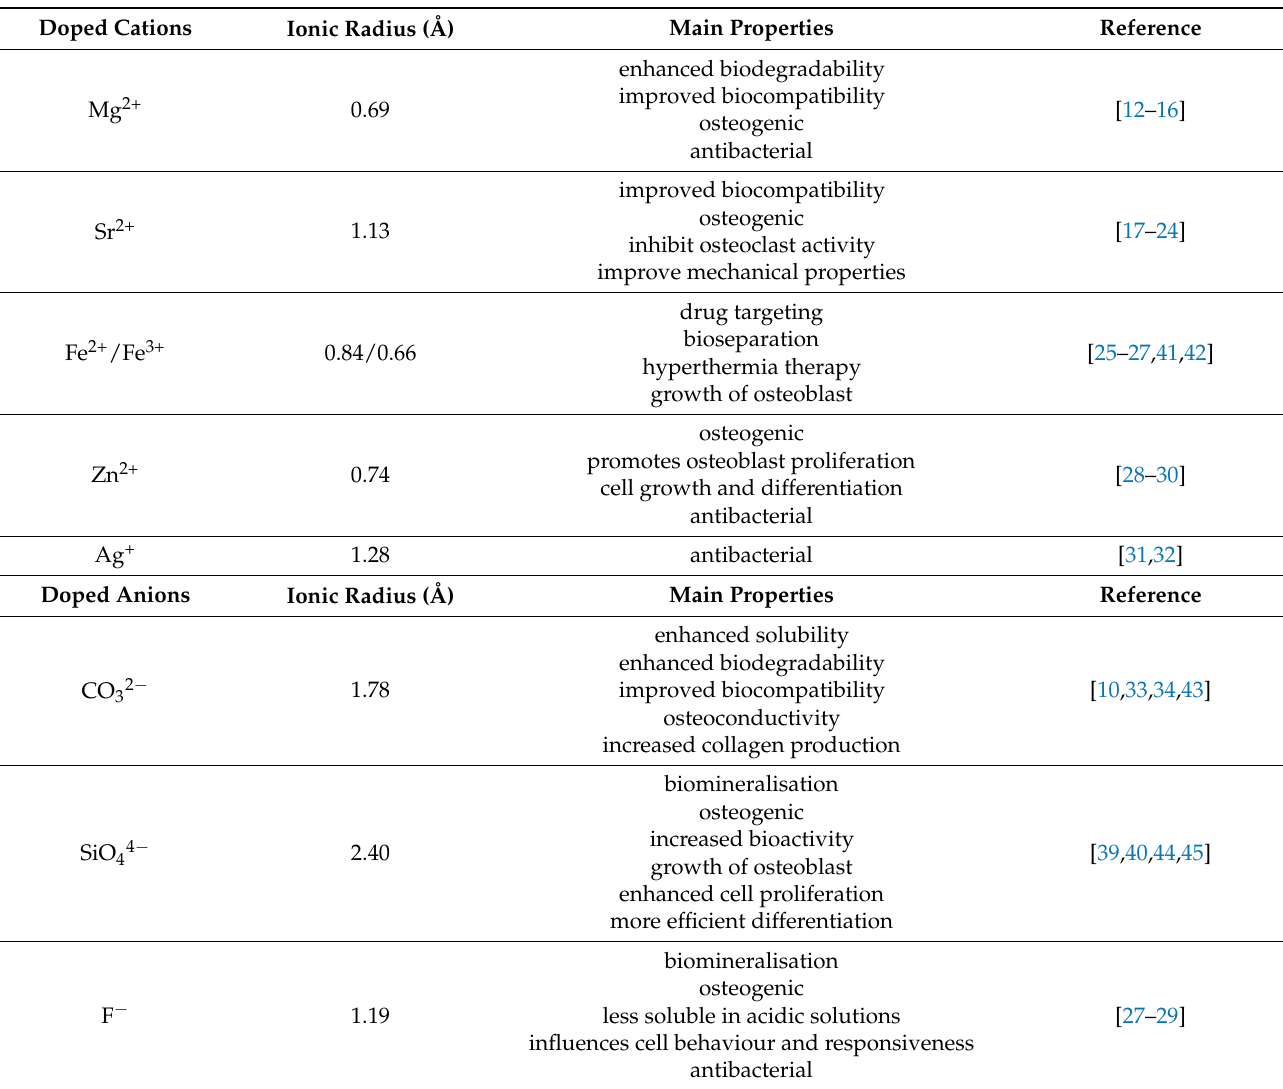
Table 1. Most common doping ions and their influence on biological properties of hydroxyapatite. The ionic radii (Å) of stoichiometric hydroxyapatite ions are Ca 2+ 0.99; PO 43 − 2.38; OH −